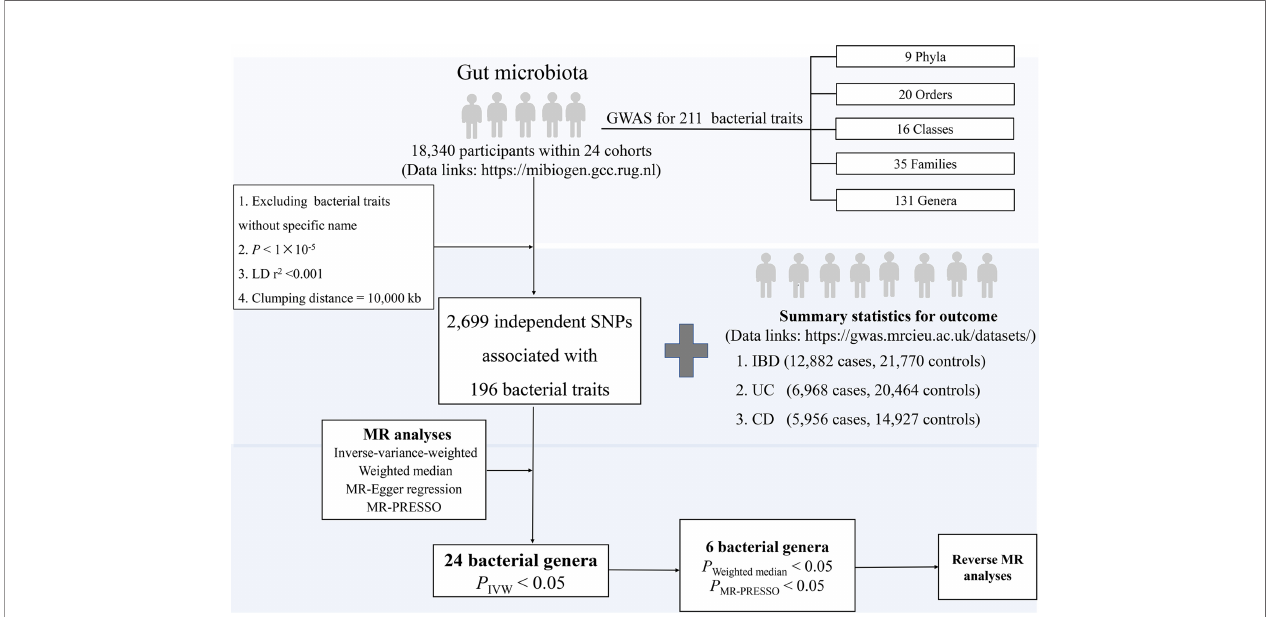
FIGURE 1 | The study design of the present MR study of the associations of gut microbiota and in fl ammatory bowel disease. Abbreviations: CD, Crohn ’ s disease; LD, linkage disequilibrium, which used to measure the correlations between SNPs; IBD, in fl ammatory bowel disease; IVW, Inverse-variance-weighted, the main analyses to evaluate the relationship between exposure and outcome; MR-PRESSO, Mendelian Randomization Pleiotropy RESidual Sum and Outlier, a method test the pleiotropic biases in the SNPs and correct the pleiotropic effects; MR, Mendelian randomization; SNP, single nucleotide polymorphism, as instrumental variables for the exposures and outcomes; UC, ulcerative